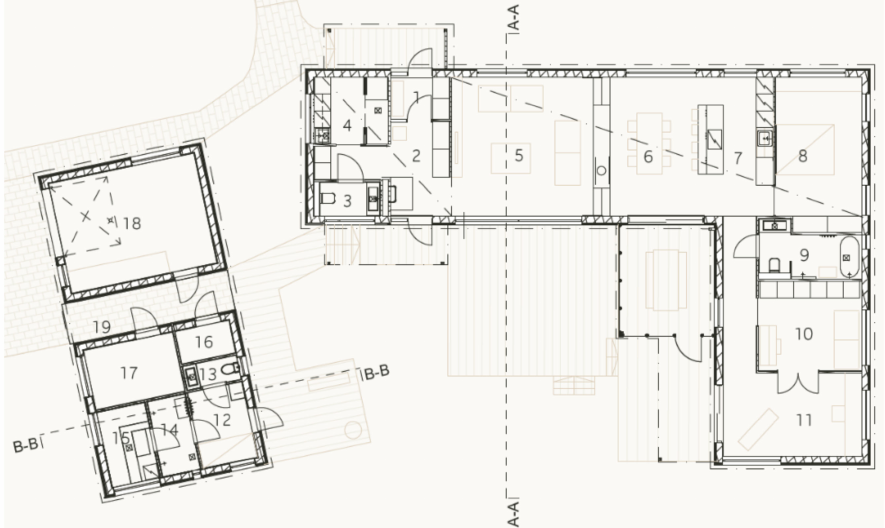
Figure 13. Floor plan: (1) wind cabinet; (2) hallway; (3) toilets; (4) housekeeping + drying; (5) living